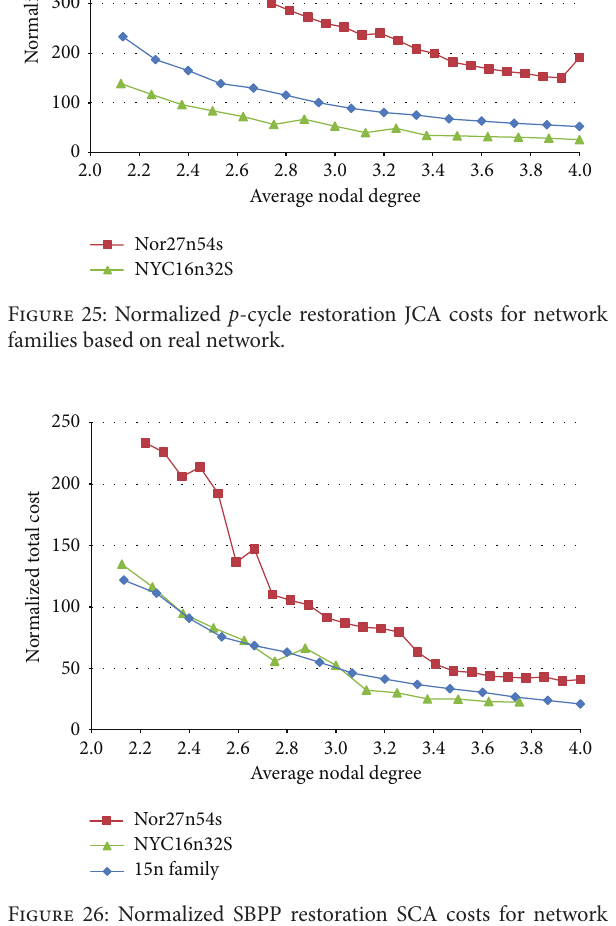
Figure 26: Normalized SBPP restoration SCA costs for network families based on real